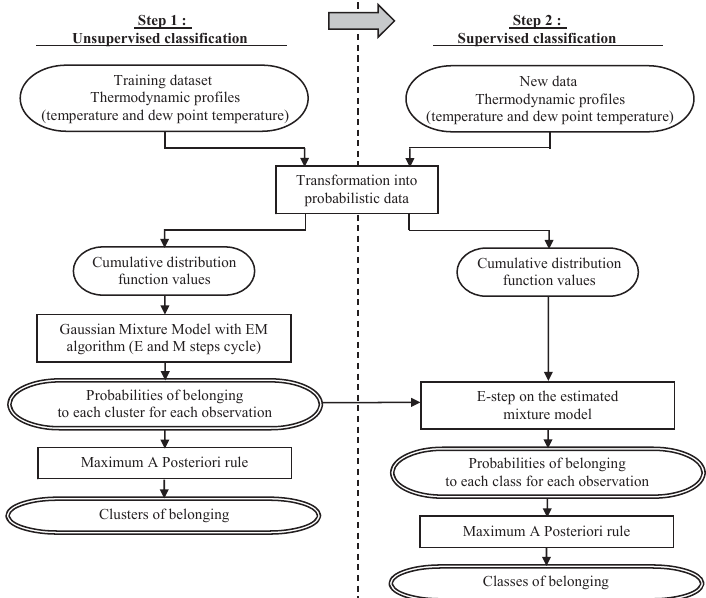
Figure 1. Principle of the methodology used in this